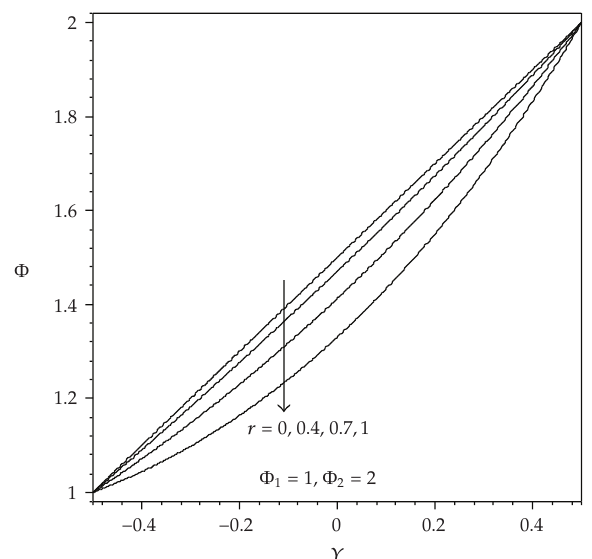
Figure 4: Concentration profiles as a function of Y for variations in the reaction-rate constant, r